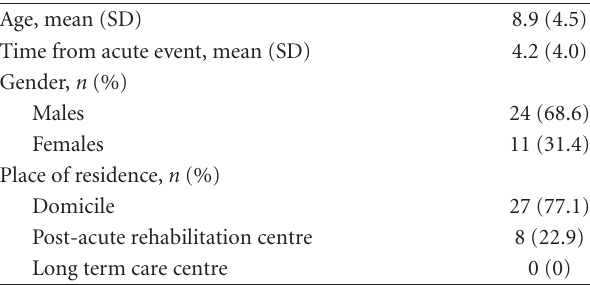
Table 1: Sociodemographic characteristics of children with DOCs.